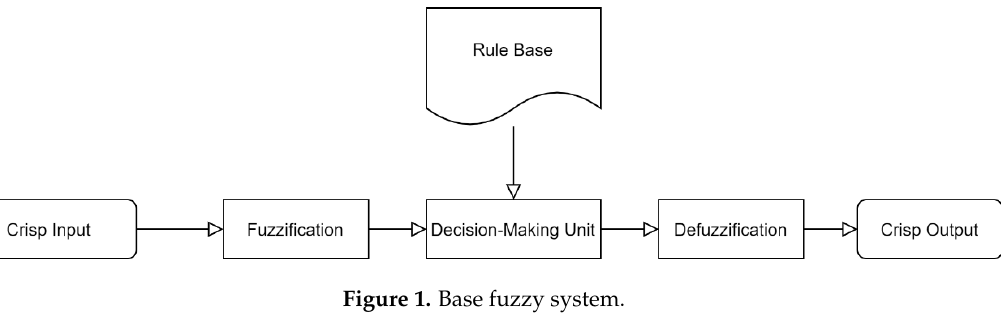
Figure 1. Base fuzzy system.